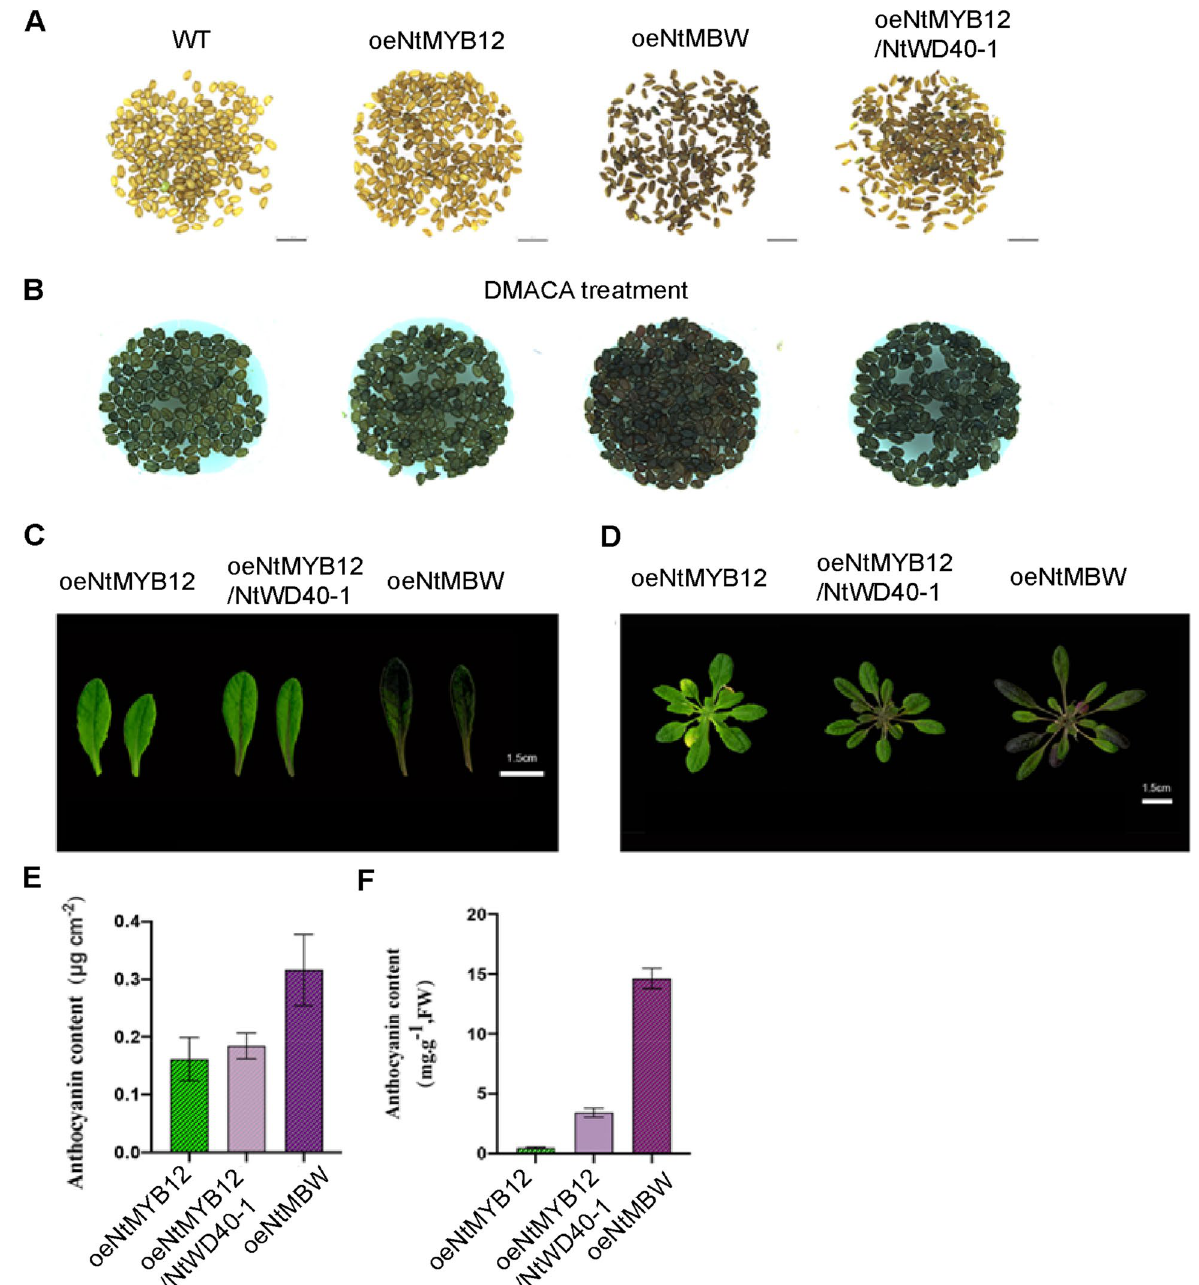
Fig. 7 Phenotypic observations of oeNtMYB12 and oeNtMBW in Arabidopsis . A‑B Observation on seed coat color of WT (Col-0), oeNtMYB12, oeNtMBW and oeNtMYB12/NtWD40-1plants before ( A ) and after DMACA staining ( B ). Sale bar germination (DAG) old oeNtMYB12 , oeNtMBW and oeNtMYB12/NtWD40-1 plants; D Rosette scanning of 31 dag-old oeNtMYB12 , oeNtMBW and oeNtMYB12/NtWD40-1 plants; E The anthocyanin content of the 7th true leaf and 31 dag-old rosettes of oeNtMYB12 , oeNtMBW and oeNtMYB12/ NtWD40-1 plants detected by portable Froce A and extraction method. Scale bar oeNtMYB12, oeNtMBW and oeNtMYB12/NtWD40-1 plants. The error bar presented standard deviants of three biological replicates ( n presents the statistical significance compared to oeNtMYB12 plants (* p < 0.05; ** p < 0.01; *** p <